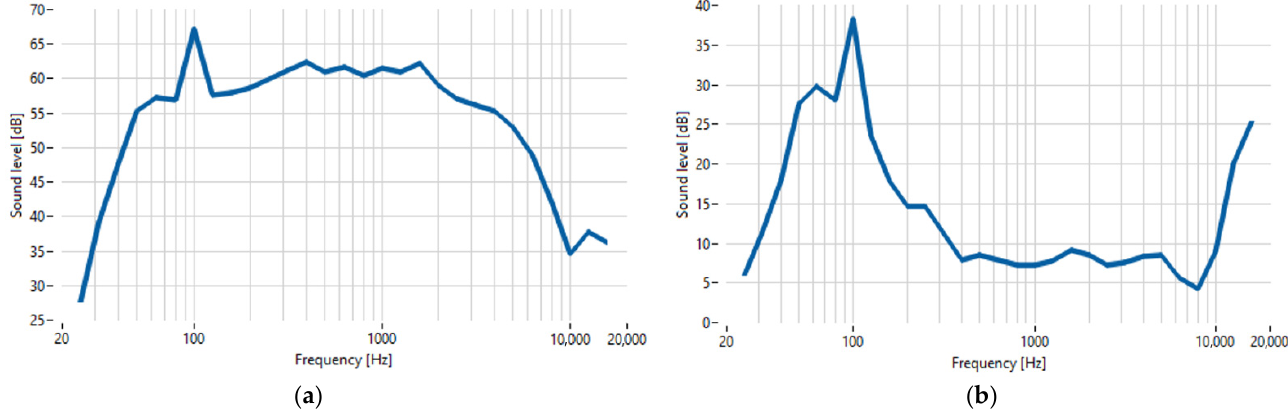
Figure 3. One-third octave band levels of the sound signal recorded outside ( a ) and inside ( b ) the anechoic chamber.